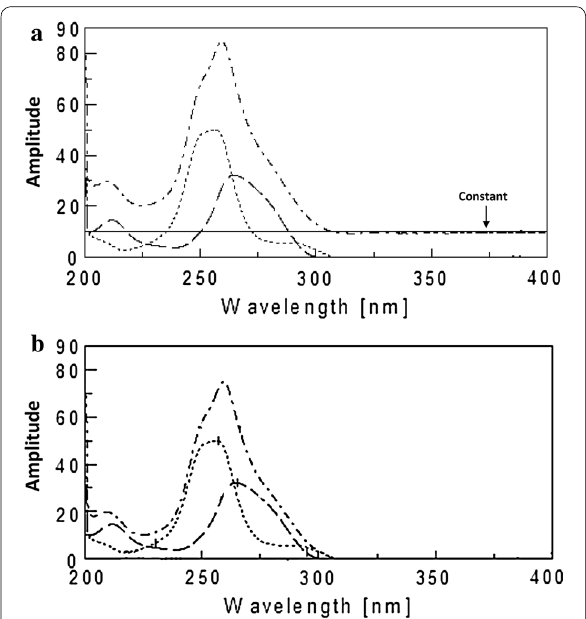
Fig. 10 Ratio spectra of DRO ( solid line ), CAF ( dashed line ), PCT ( dotted line ) and their ternary mixture ( dashed dotted line ) containing 10 μg/ mL of each using normalized DRO spectrum as a divisor. b Ratio spectra of CAF ( dashed line ), PCT ( dotted line ) and their resolved binary mixture ( dashed dotted line ) containing 10 μg/mL of each using nor- malized DRO spectrum as a divisor after subtraction of the obtained